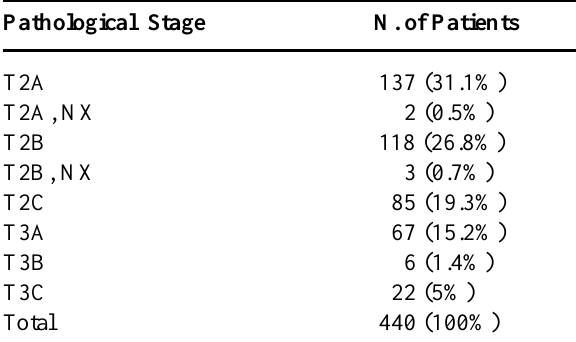
Table 4 – Patient distribution according to pathological stage.